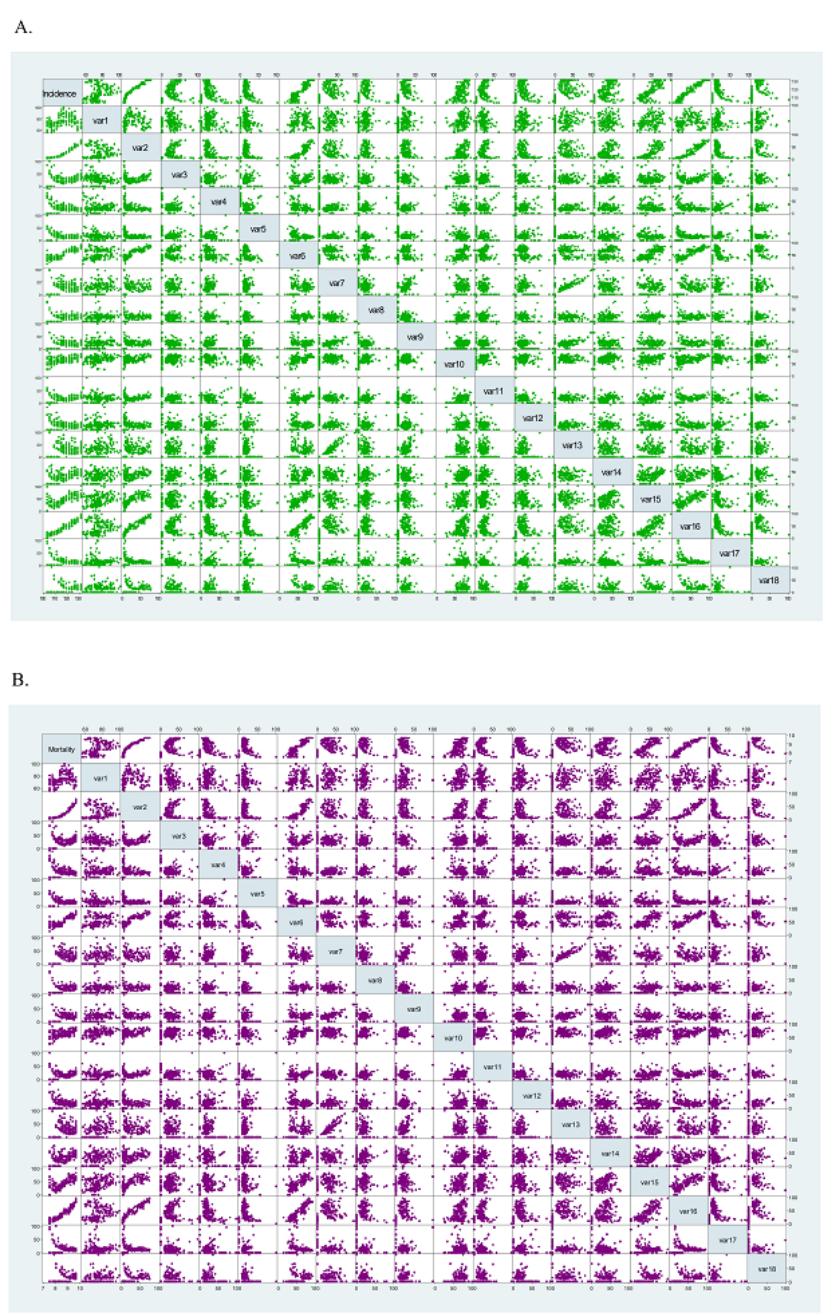
Figure 2. (A) Scatter plot of relative search volumes and incidence rate of atrial fibrillation and flutter in the United States. (B) Scatter plot of relative search volumes and mortality rate of atrial fibrillation and flutter in the United